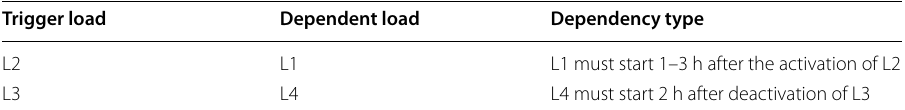
Table 5 Characteristics of dependencies in use case II